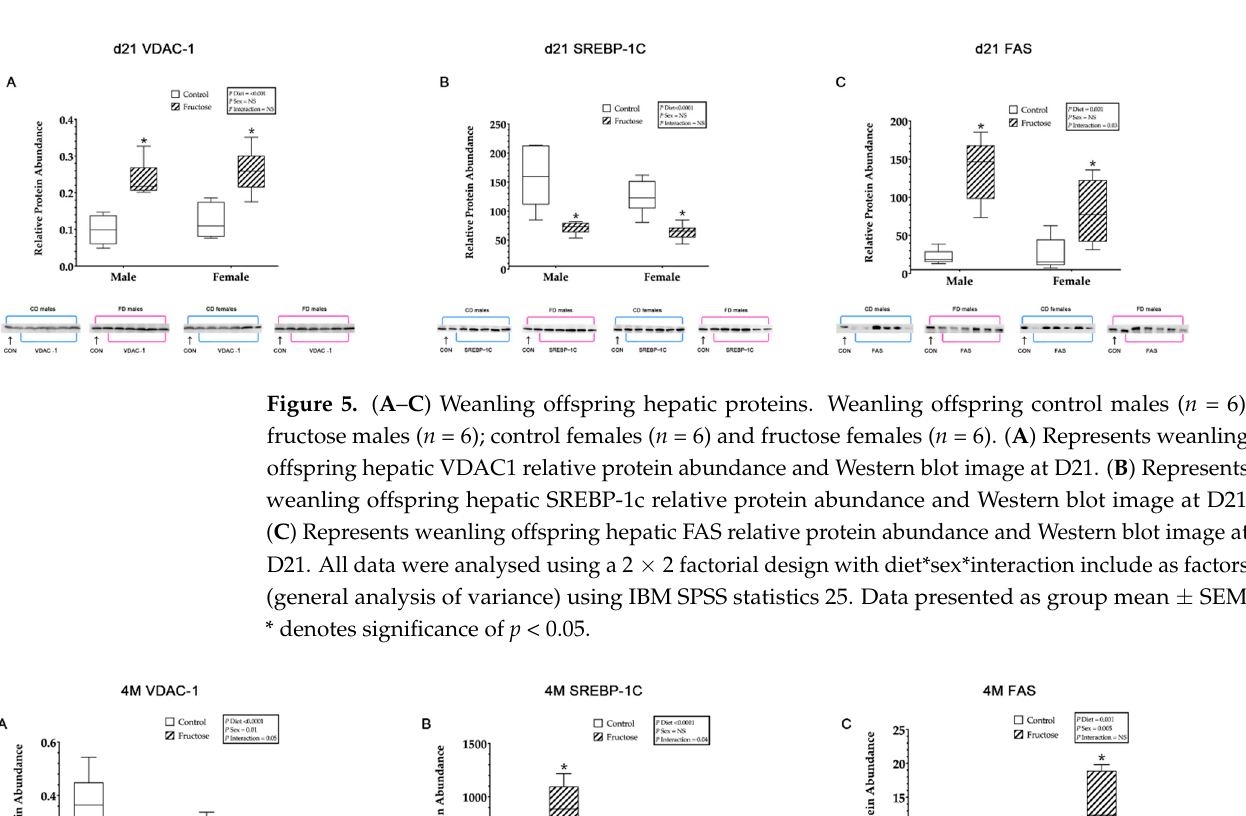
Figure 6. ( A – C ) Adult offspring hepatic proteins. Adult offspring control males ( n = 6); fructose males ( n = 6); control females ( n = 6) and fructose females ( n = 6). ( A ) Represents adult offspring hepatic VDAC1 relative protein abundance and Western blot image at 4 M. ( B ) Represents adult offspring hepatic SREBP-1c relative protein abundance and Western blot image at 4 M. ( C ) Represents adult offspring hepatic FAS relative protein abundance and Western blot image at 4 M. All data were analysed using a 2 × 2 factorial design with diet*sex*interaction include as factors (general analysis of variance) using IBM SPSS statistics 25. Data presented as group mean ± SEM. * denotes significance of p < 0.05.